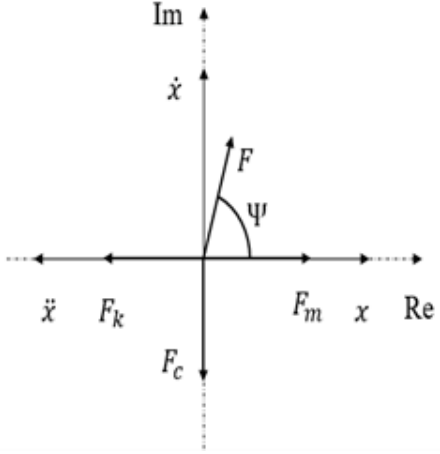
Figure 3. Schematic diagram of the force balance of the linear compressor mover.